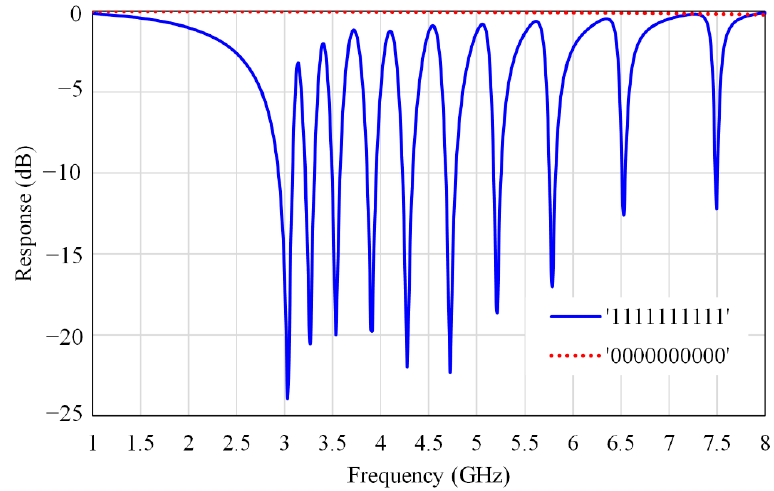
Figure 5. Simulated response of the M − strips tag with two different codes: 1111111111 and 0000000000.